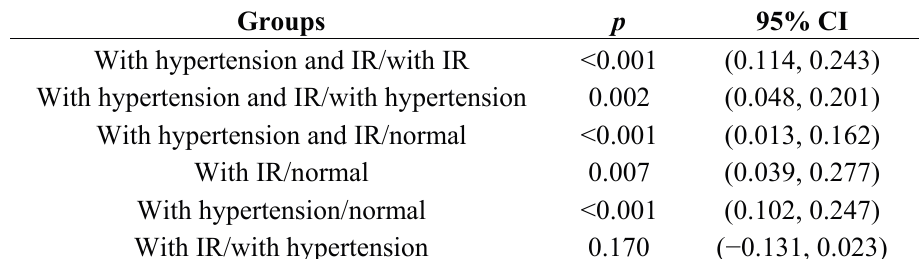
Figure 1. Comparisons of adjusted means among the four groups. Table 3. Multiple comparisons of adjusted mean FFA